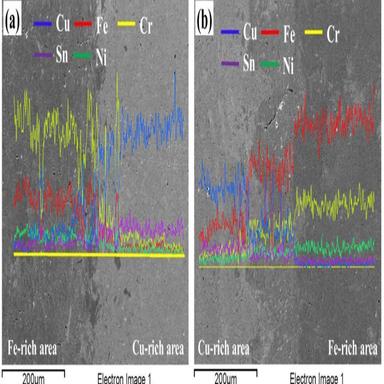
(a) EDS line scan at the C/L interface; (b) EDS line scan at the L/C interface.